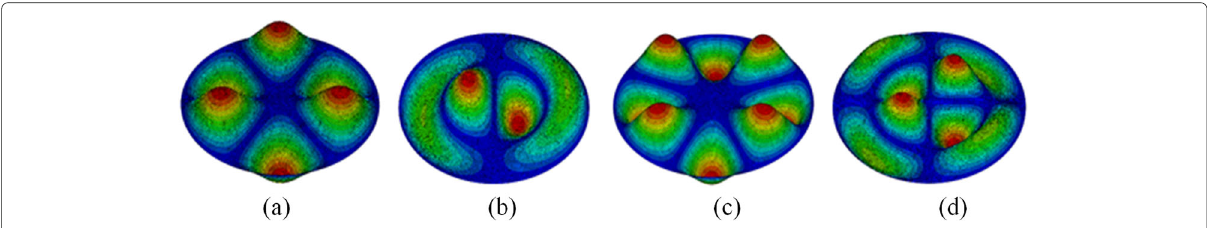
Fig. 19 Additional mode shapes that were identified with FEA: a mode (3,1) at 207.6 Hz, b mode (1,2) at 228.3 Hz, c mode (4,1) at 246.9 Hz and d mode (2,2) at 273.8